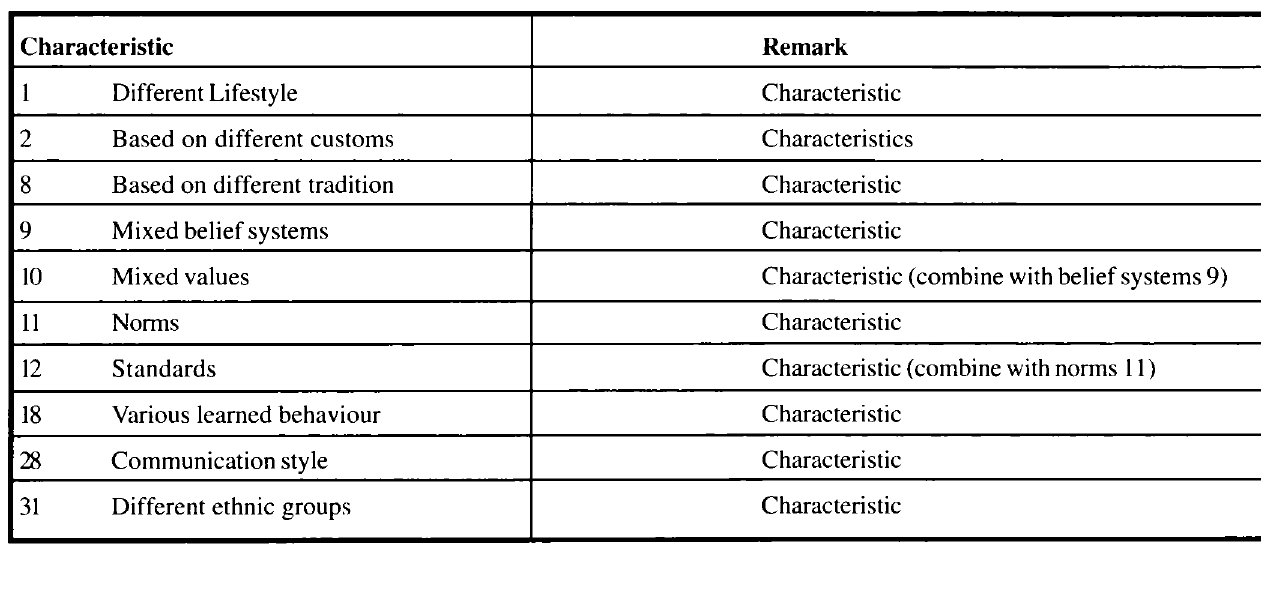
Table 2: Initial characteristics of cultural